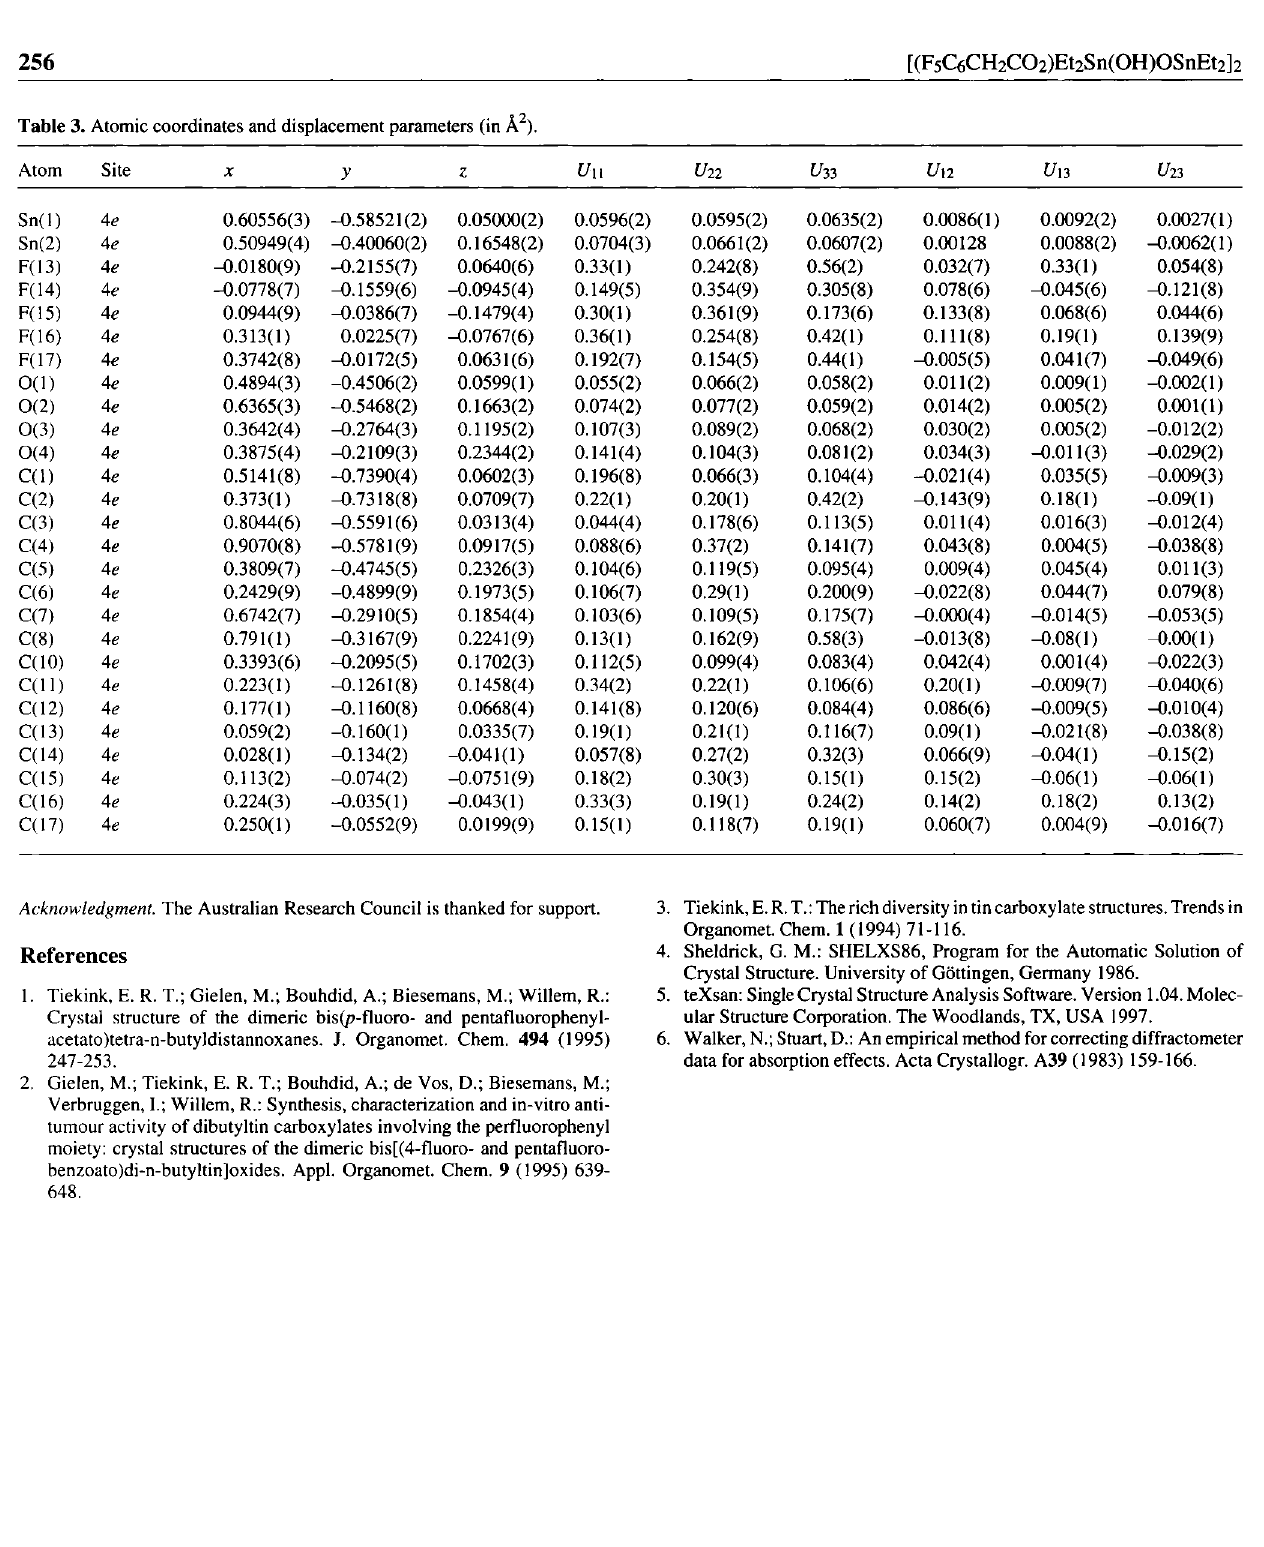
Table 3. Atomic coordinates and displacement parameters (in Ä 2 ).